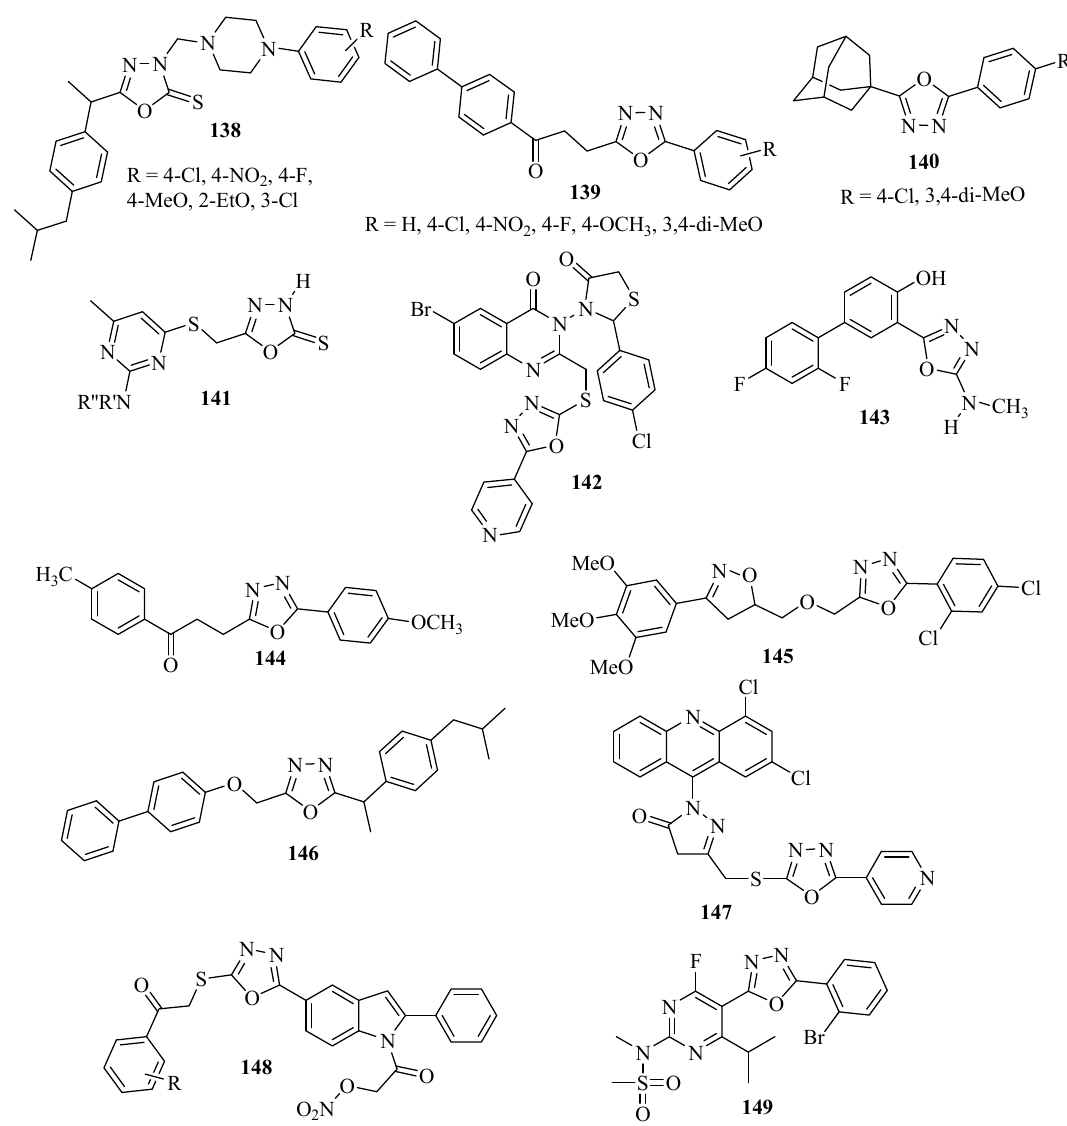
Figure 8. 1,3,4-Oxadiazoles with anti-inflammatory